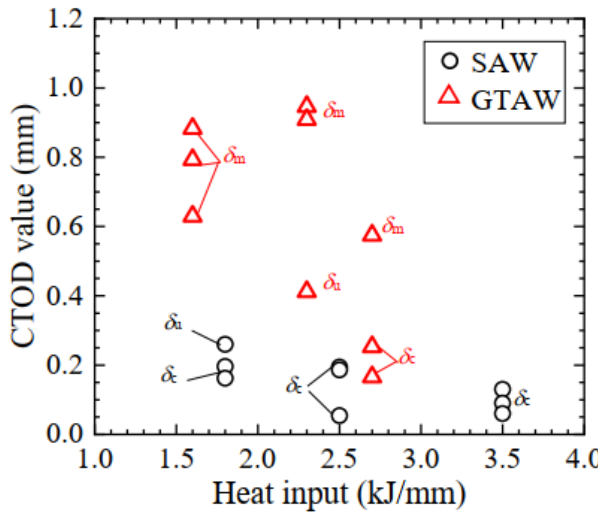
Figure 17. Relationship between CTOD value and heat input for SAW and GTAW weld joint at F.L. (test temperature: 273 K).